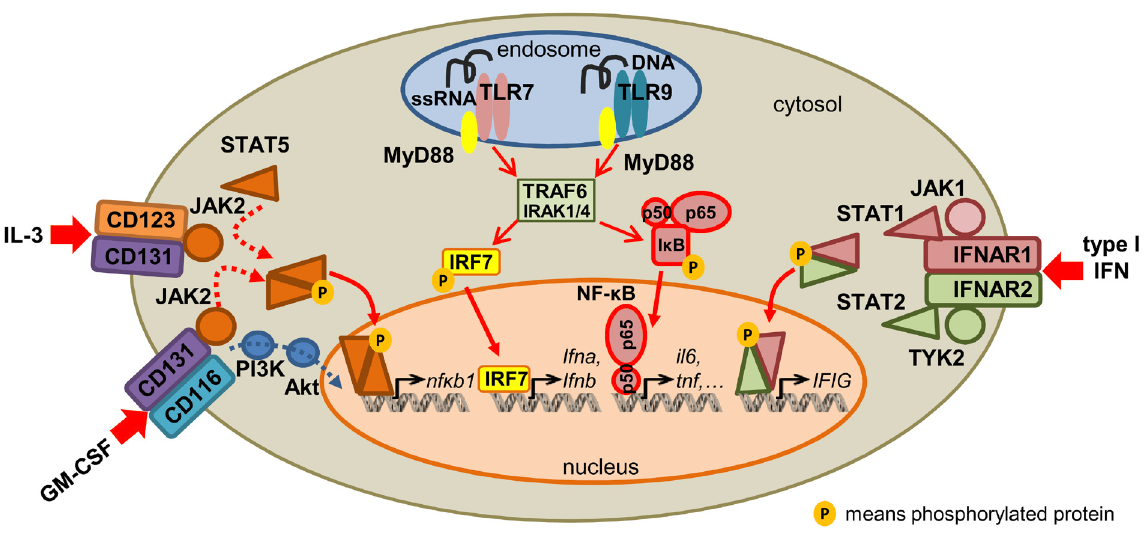
Figure 1. The main signaling pathways in plasmacytoid dendritic cells that promote metabolic changes or are modulated by metabolic pathways. This figure summarizes different signaling pathways described in the literature to promote metabolic changes or to be modulated by immunometabolism in plasmacytoid dendritic cells. This includes: endosomal TLR 7 and TLR9, membrane IL-3 receptor (associating CD131 to CD123), GM-CSF receptor (associating CD131 to CD116), and IFN- α receptor (IFNAR associating IFNAR1 and IFNAR2). Only the main pathways with main effector molecules are depicted. For more details, please refer to the main text. Abbreviations (not defined in the main text): IFIG , IFN-I-induced genes; nf κ B1 , NF- κ B